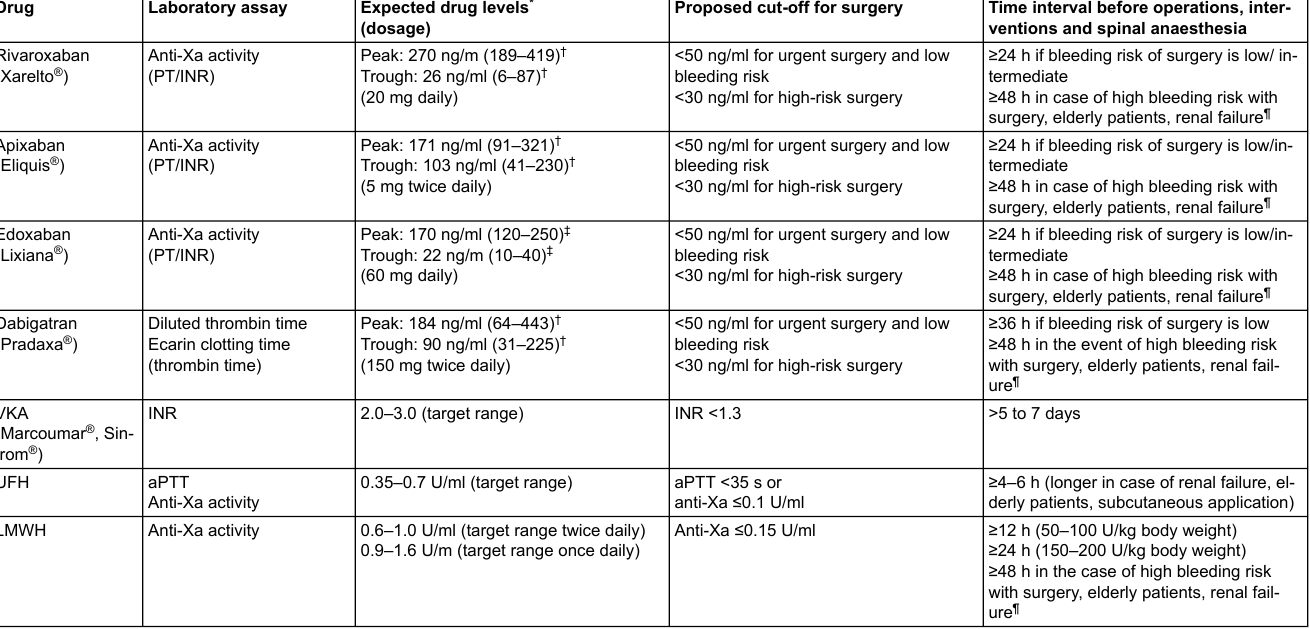
Table 3: Laboratory tests, expected drug levels, critical drug levels and required time interval before